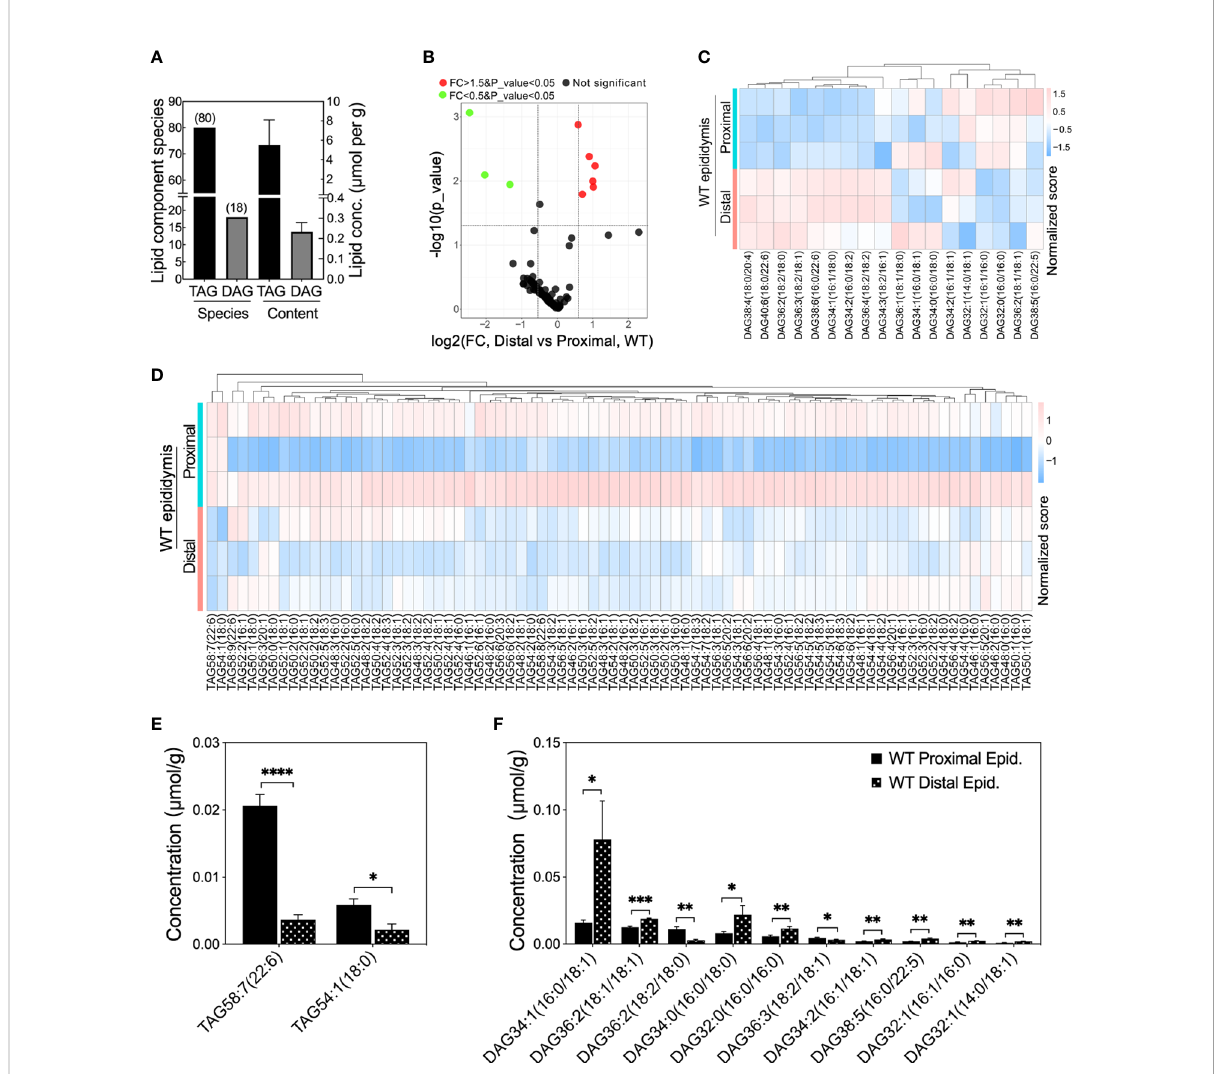
FIGURE 5 Lipid compositions at different levels in proximal and distal epididymis of WT mice. (A) Lipid compositions and contents detected in mouse epididymis. (B) Volcano plot of fold change (FC) of TAG and DAG component concentrations detected in the distal versus proximal epididymis of WT mice. Proximal epididymis annotated the samples from regions 1 to 6 whereas distal epididymis annotated the regions from 7 to 10 (n > 3 animals per group). Green dots represent speci fi c lipid concentrations signi fi cantly less than 0.5 fold changes (FC) and red dots for those 1.5 folds greater, P <0.05 for both; black dots represent those lipid components have no difference in lipid concentrations. (C) Heatmap showing the row-normalized contents of DAG components in the proximal and distal epididymis of WT mice. (D) Heatmap showing the variations of the row-normalized contents of TAG components in the proximal and distal epididymis of WT mice. (E) Signi fi cantly lower levels of speci fi c TAG components and prominent heterogeneous levels of DAG components (F) in the distal epididymis compared to the proximal epididymis of WT mice. Data were means ± SD, two-tailed unpaired t- test, * P< 0.05, ** P < 0.01, *** P < 0.001, **** P < 0.001 (n > 3 experiments per